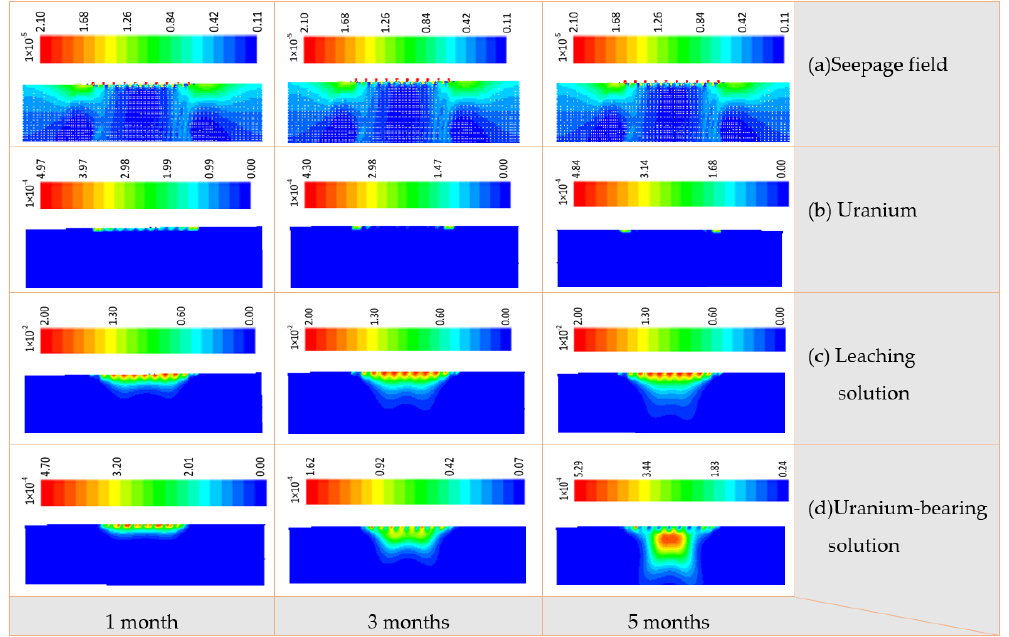
Figure 7. Multifield coupling evolution in stope ventilation. ( a ) Seepage field; ( b ) Uranium; ( c ) Leaching solution; ( d ) Uranium-bearing solution.